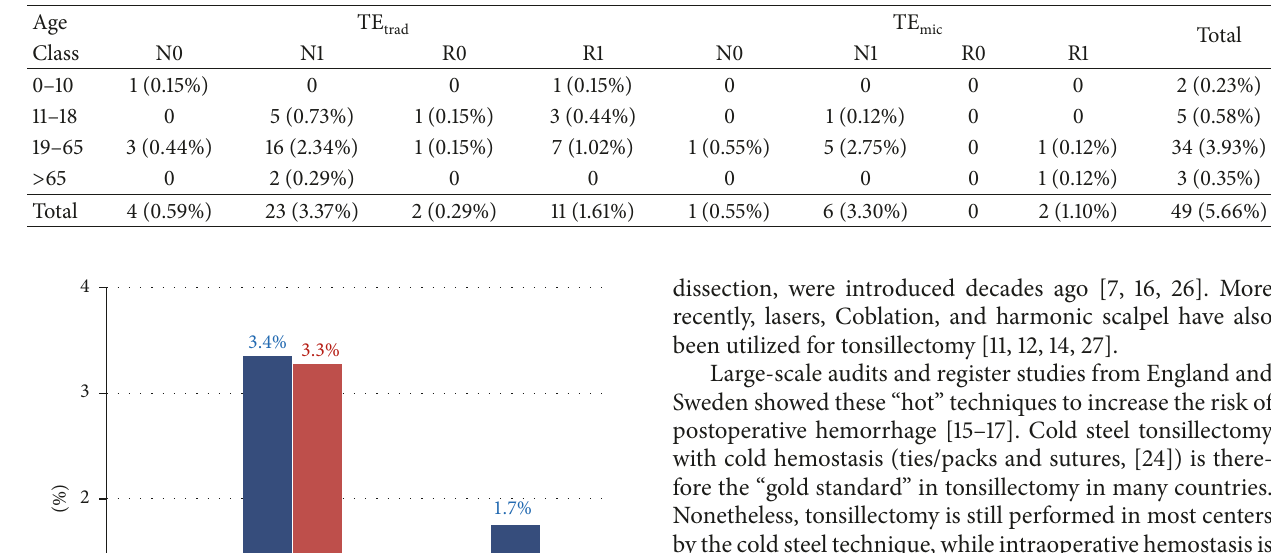
Table 5: PTH rates broken down by the N-/R-classification and age groups.